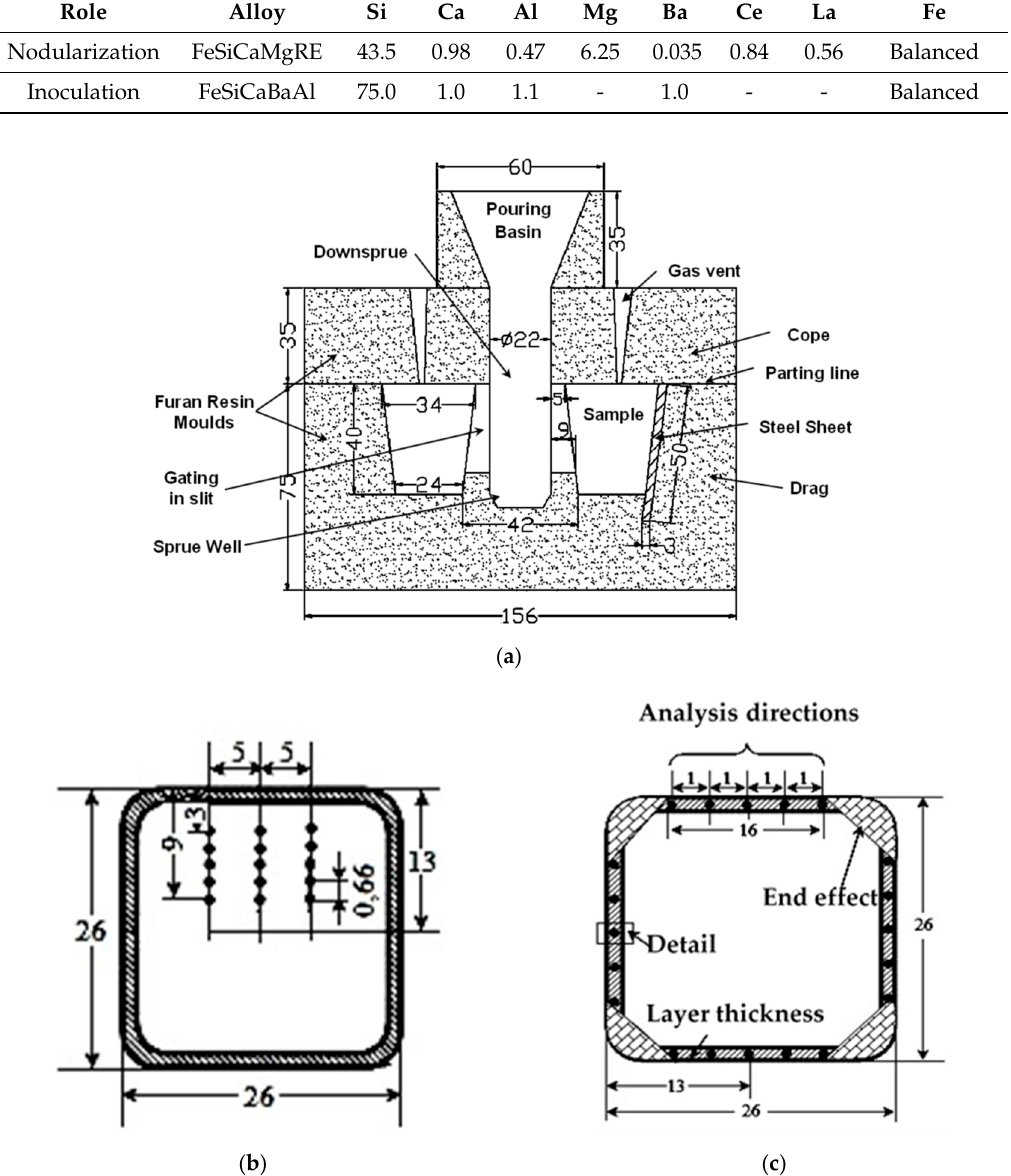
Figure 2. Pyramid trunk with square section test sample ( a ) resin sand mould assembly; ( b ) structure analysis in the casting body; ( c ) structure analysis in the casting surface layer. (Unit: